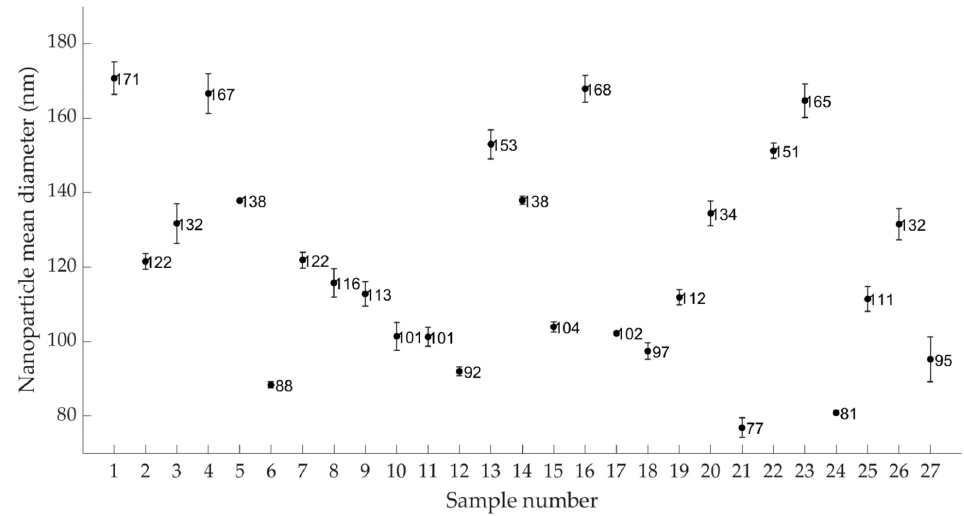
Figure 2. Mean nanoparticle diameter per sample group (1–27) (95% CI).